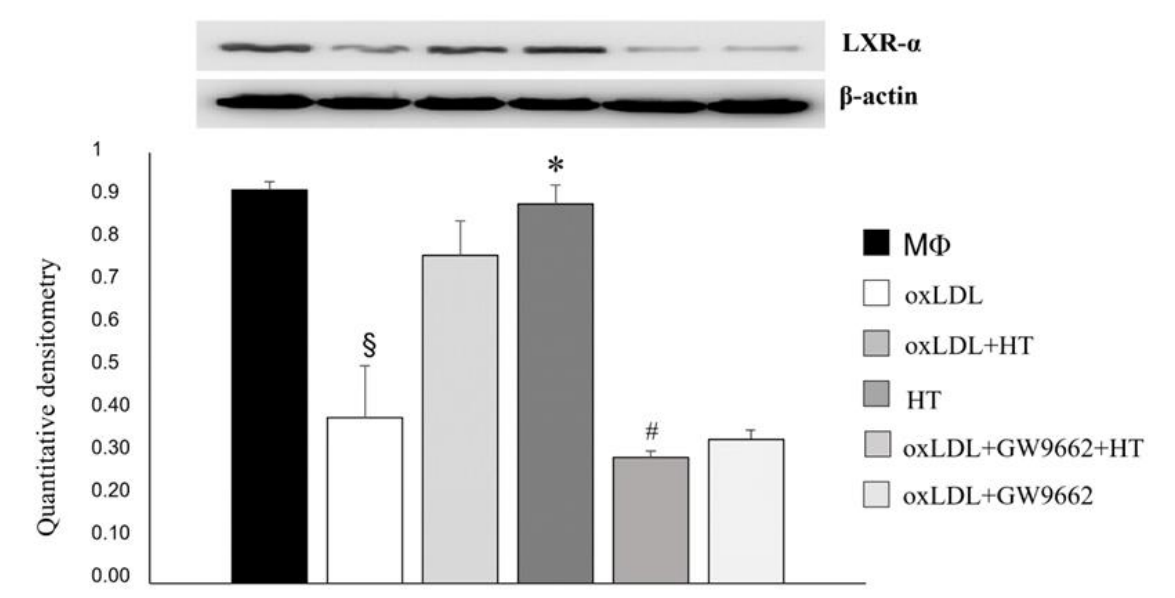
Figure 7. LXR α is involved in the upregulation of ABCA1 induced by HT. THP-1 macrophage- derived foam cells were incubated with GW9662, a PPAR γ antagonist, and treated with HT (50 µ M). Figure 7. LXRα is involved in the upregulation of ABCA1 induced by HT. THP -1 macrophage- de- Then, Western blot analyses were performed. § p < 0.001 vs. M Φ ; * p < 0.001 vs. ox-LDL; # p < 0.001 rived foam cells were incubated with GW9662, a PPARγ antagonist, and treated with HT (50 μM). vs. ox-LDL + HT ( n = 3). HT, hydroxytyrosol; oxLDL, oxidized low-density Then, Western blot analyses were performed. § p < 0.001 vs. MΦ; * p < 0.001 vs. ox-LDL; # p < 0.001 vs. ox-LDL + HT ( n = 3). HT, hydroxytyrosol; oxLDL, oxidized low-density lipoprotein.